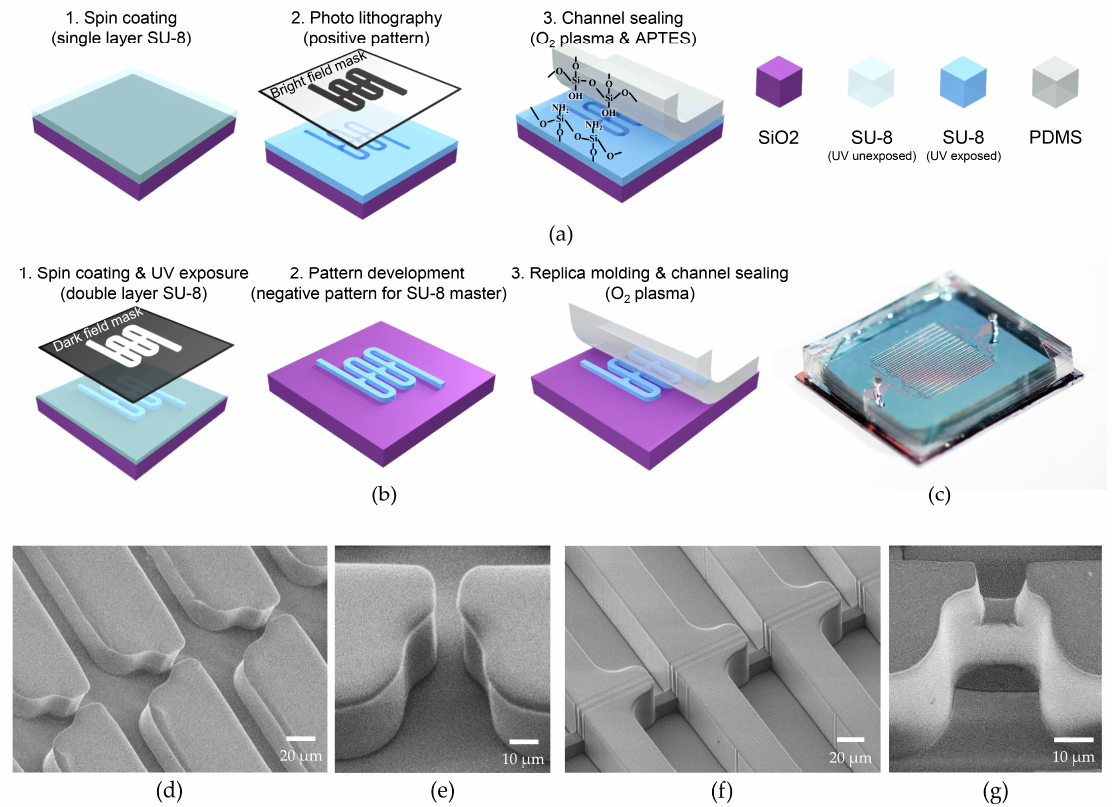
Figure 3. Fabrication of flow-restricted microfluidic trap array: ( a ) fabrication process of ( a ) LR-type and ( b ) fVR-type devices; ( c ) optical image of a flow-restricted microfluidic trap array; ( d ) SEM image of an LR-type device and ( e ) its capture site; ( f ) SEM image of an SU-8 master for an fVR-type device and ( g ) its poly(dimethylsiloxane) (PDMS) molded capture site.